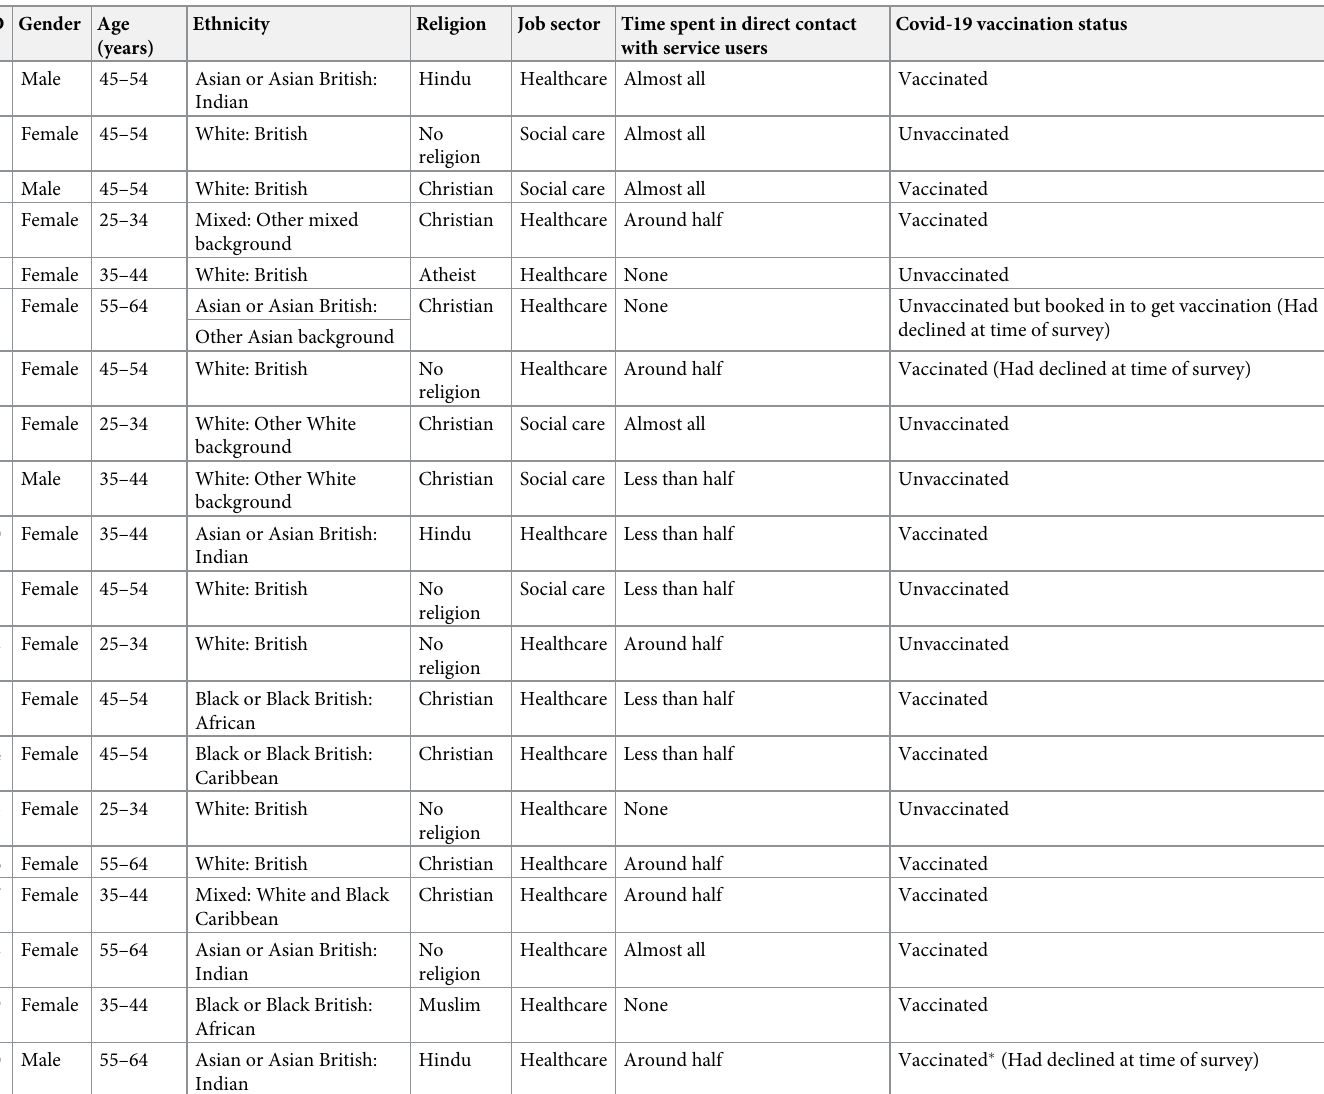
Table 4. Interview participant